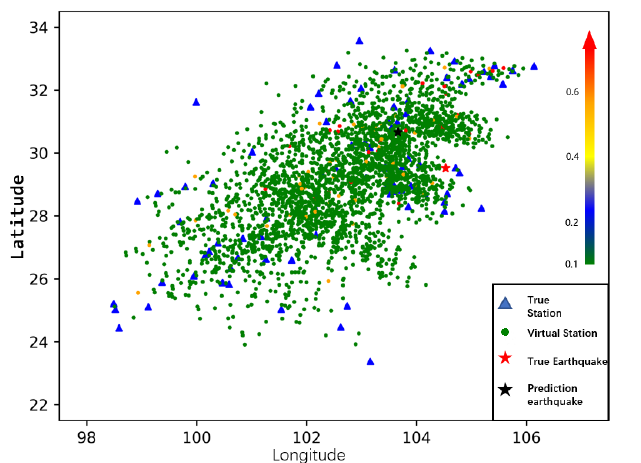
Figure 6. Multi-PCA map. The red star is the earthquake, and the black star is the predicted epicenter. Green points are virtual stations, which are located at the center of two